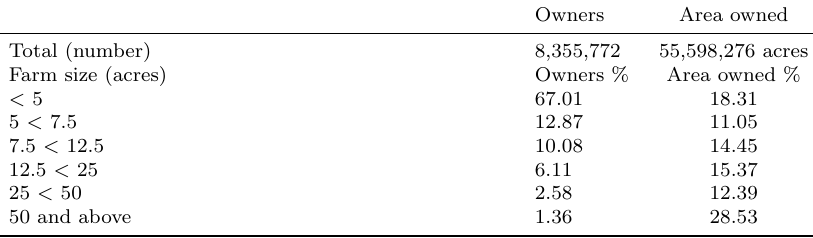
Table 1: Distribution of land ownership by farm size in Pakistan, 2010 Owners Area